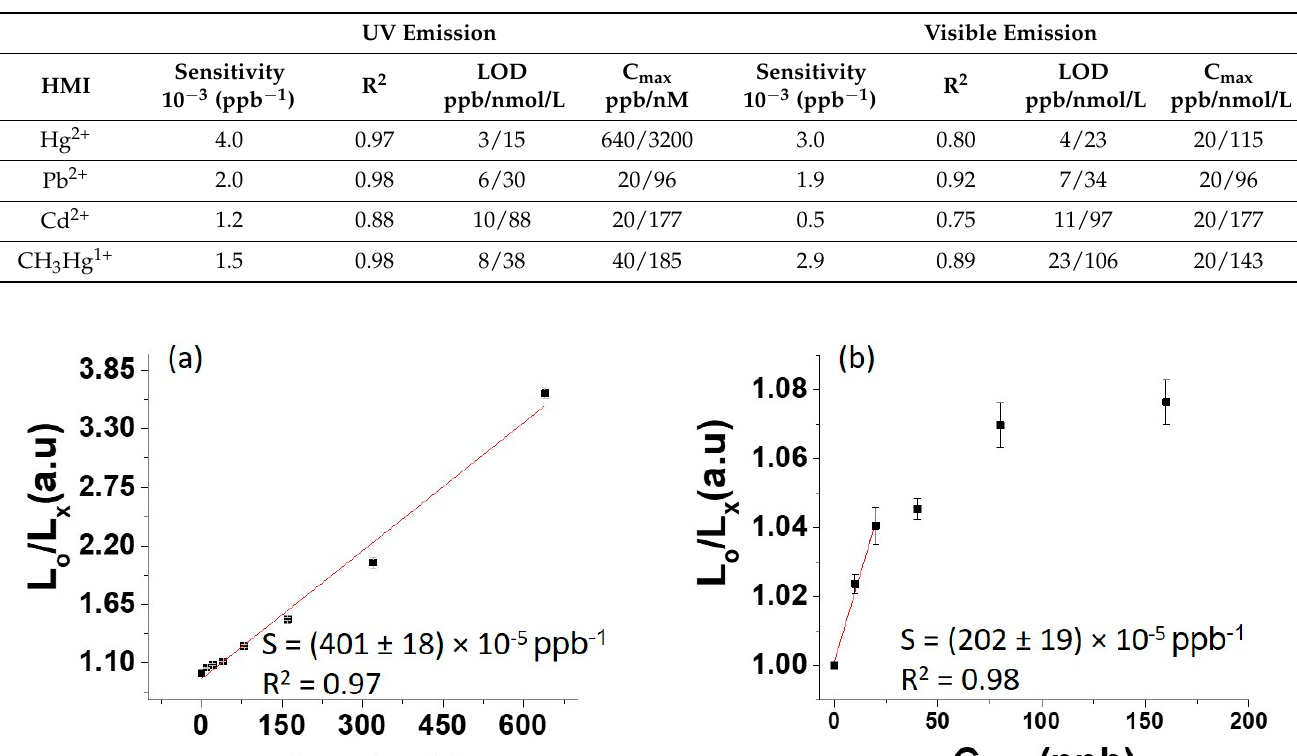
Table 2. Comparison of sensitivity (S), linearity constant (R 2 ), limit of detection (LOD) and linearity range (C max ) in the PL quenching of the AuNCs synthesized by PLA upon interaction with the different HMIs.